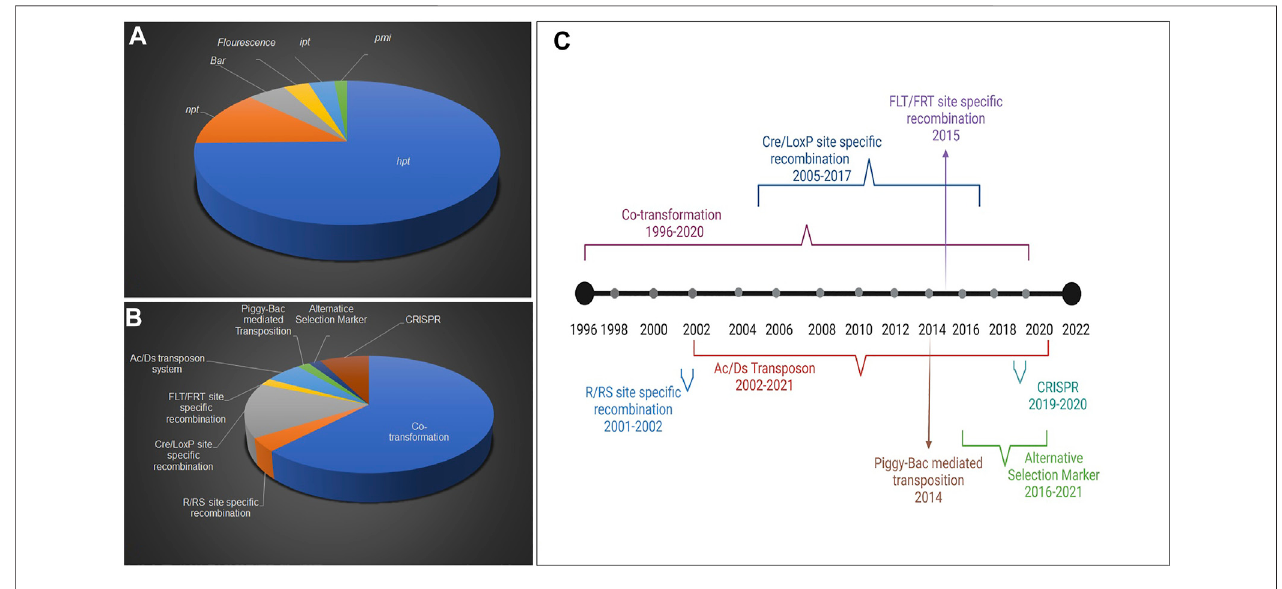
FIGURE 1 | Status of selectable markers used for the generation of SMG-free transgenic rice. Representation of various selectable markers contribution (A) , Timeline representation of SMG-free techniques used in rice (B) , Proportion of different molecular approaches in developing SMG-free engineered rice (C) .